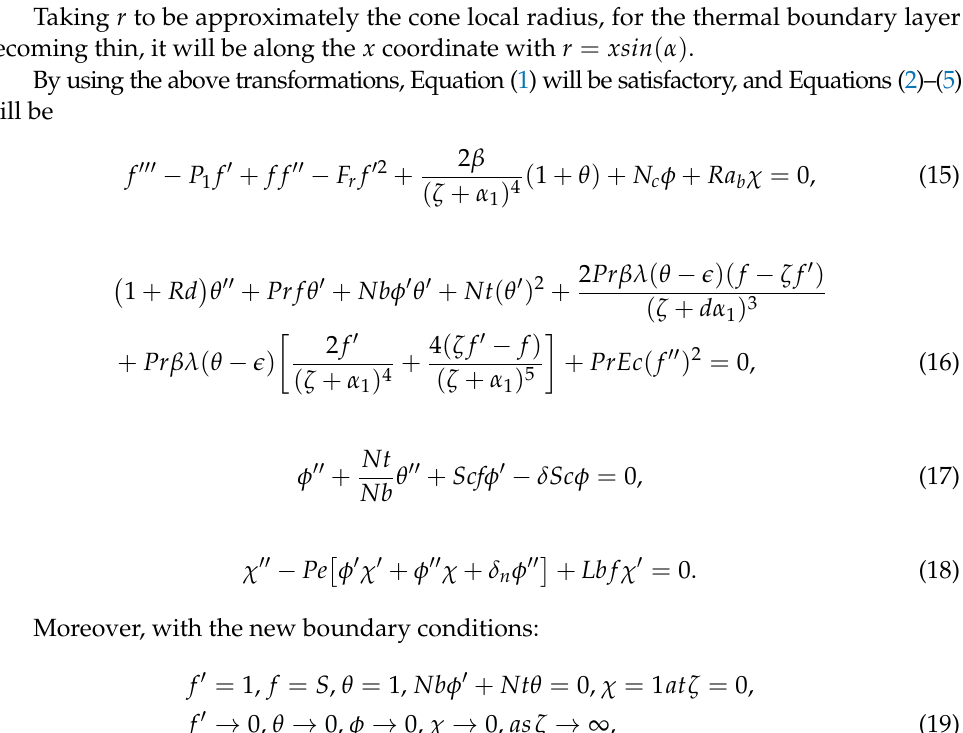
Figure 1. A picture scheme of the